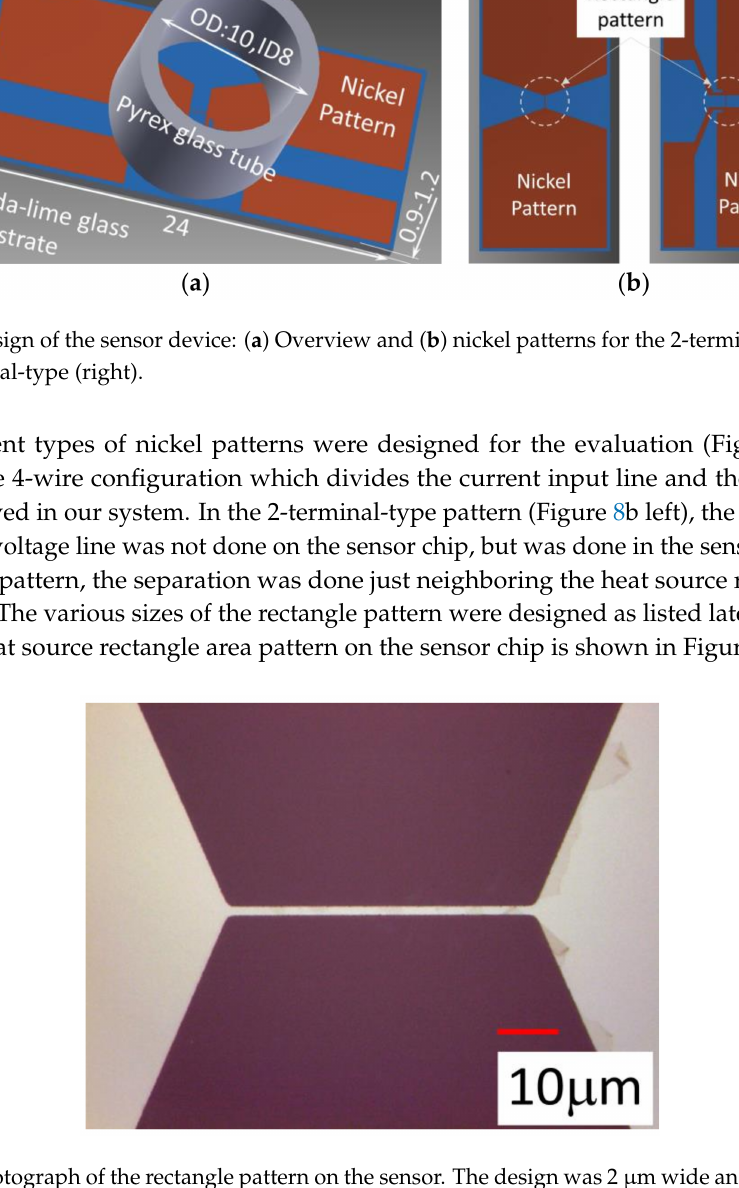
diameter, 10 mm; length, approx. 20 mm, Ookabe Glass HD., Fukui, Japan) was glued to the